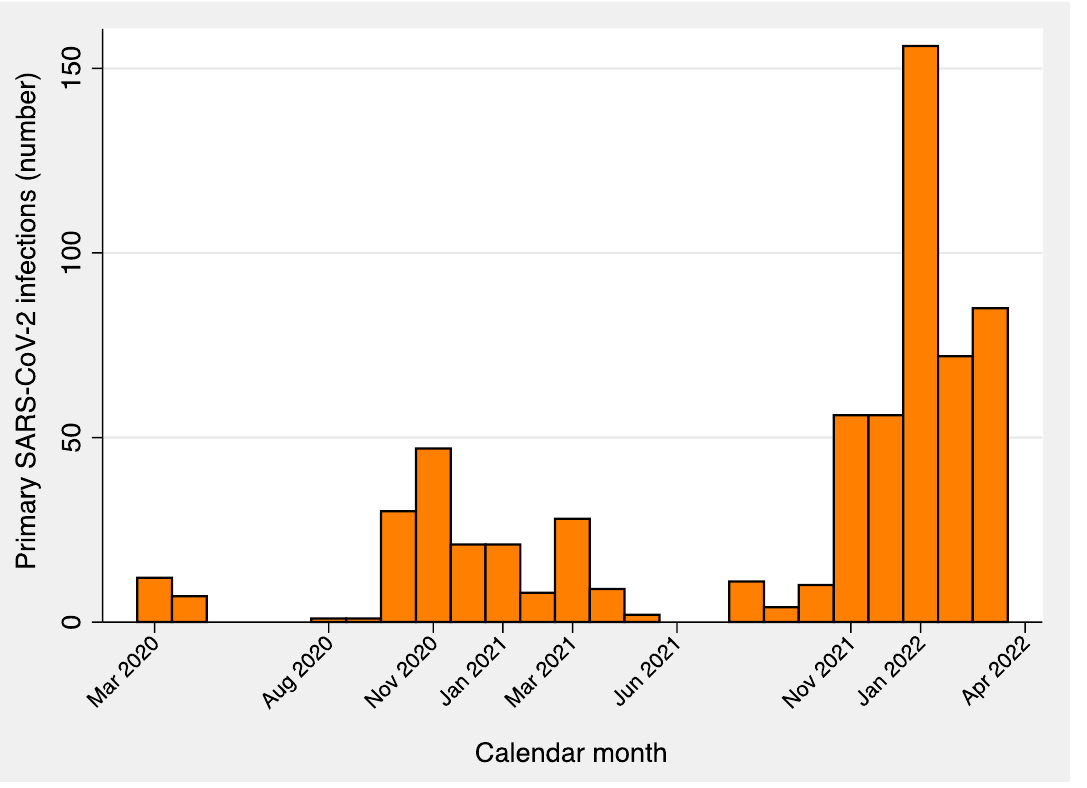
Figure 2. Distribution of primary SARS-CoV-2 infections by calendar month (1 March 2020 – 2 April 2022) among workers of the University of Trieste.